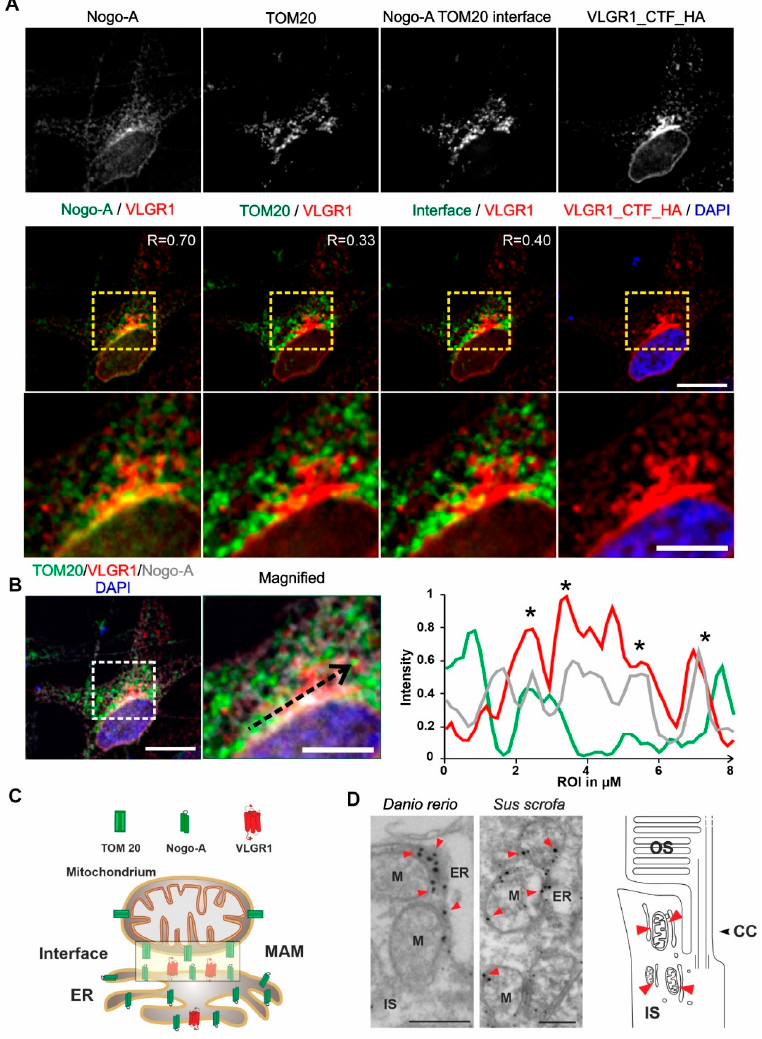
Figure 3. VLGR1_CFT localizes at the ER-mitochondria interface and is present at mitochondrial membranes in photoreceptor cells. ( A ) Immunocytochemical localization analysis of VLGR1_CTF at the ER-mitochondria interface in HeLa cells. Noga-A and TOM20 were used as markers for the